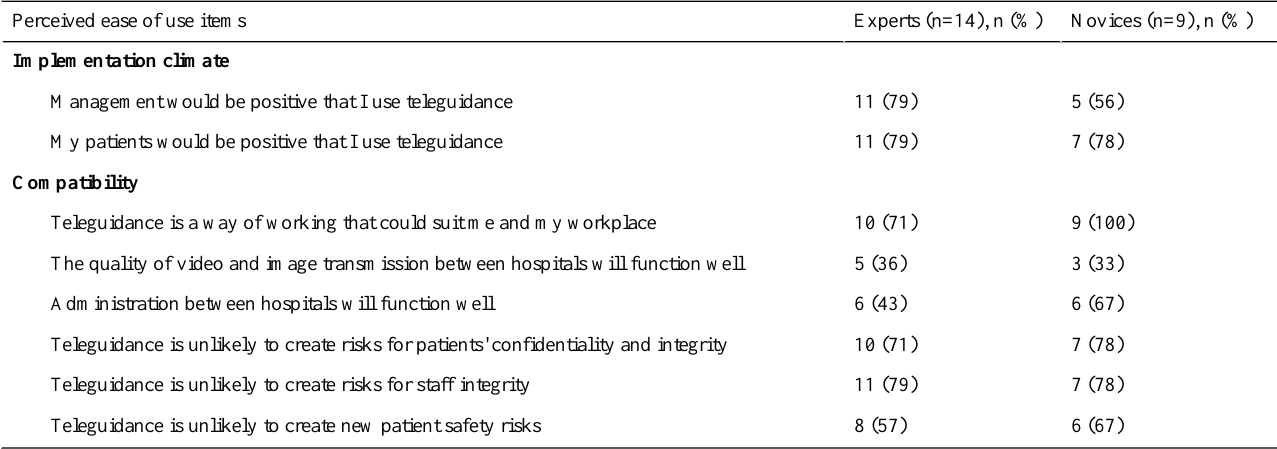
Table 2. Dichotomized agreement scores on implementation climate and compatibility by experts and novices in endoscopic retrograde